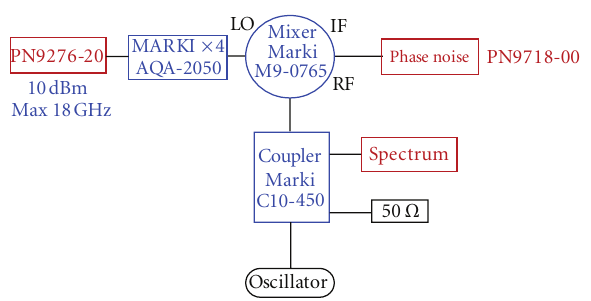
Figure 24: Principle of realized phase noise bench.